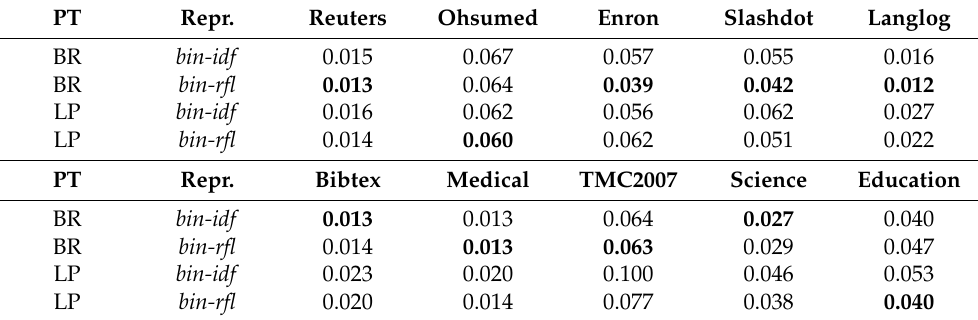
Table 9. Experimental results of different transformations of the problem (PT: BR and LP), and Representations with ANN in terms of Hamming Loss.